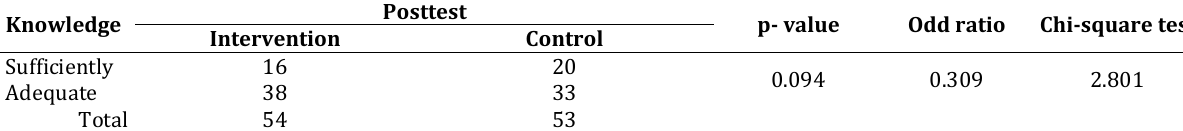
Table 2. Statistical result of Demavi effect on housewive s’ knowledge of first aid in burns